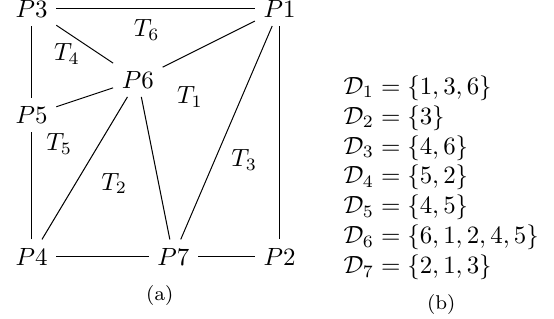
Figure 5: In 5a a top view of a TIN with vertices P l , l ∈ { 1 , . . . , 7 } is presented, and 5b shows the corresponding sets D l of indices to triangles which have P l as a common